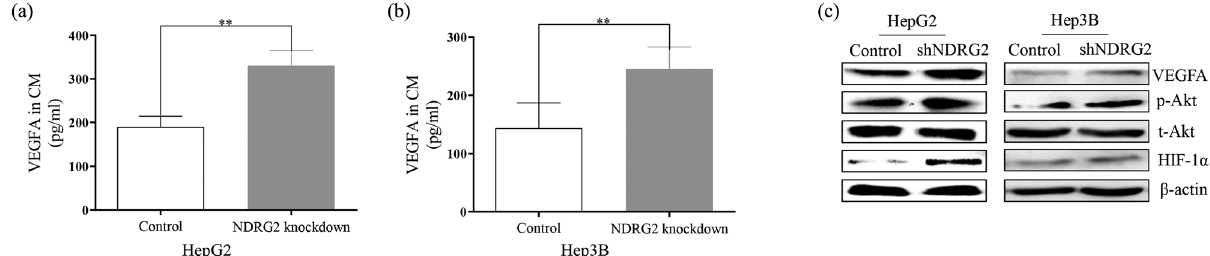
Figure 2: NDRG2 knockdown increased the level of secretory VEGFA. We examined the changes of VEGFA levels in CM from HepG2 and Hep3B cell culture following NDRG2 knockdown using ELISA. ( a – b ) The level of VEGFA was increased by NDRG2 knockdown relative to the control group. ( c ) The expression of VEGFA, HIF - 1 α , and p - Akt were upregulated in NDRG2 knockdown cells compared with control cells. ** P < 0.01.